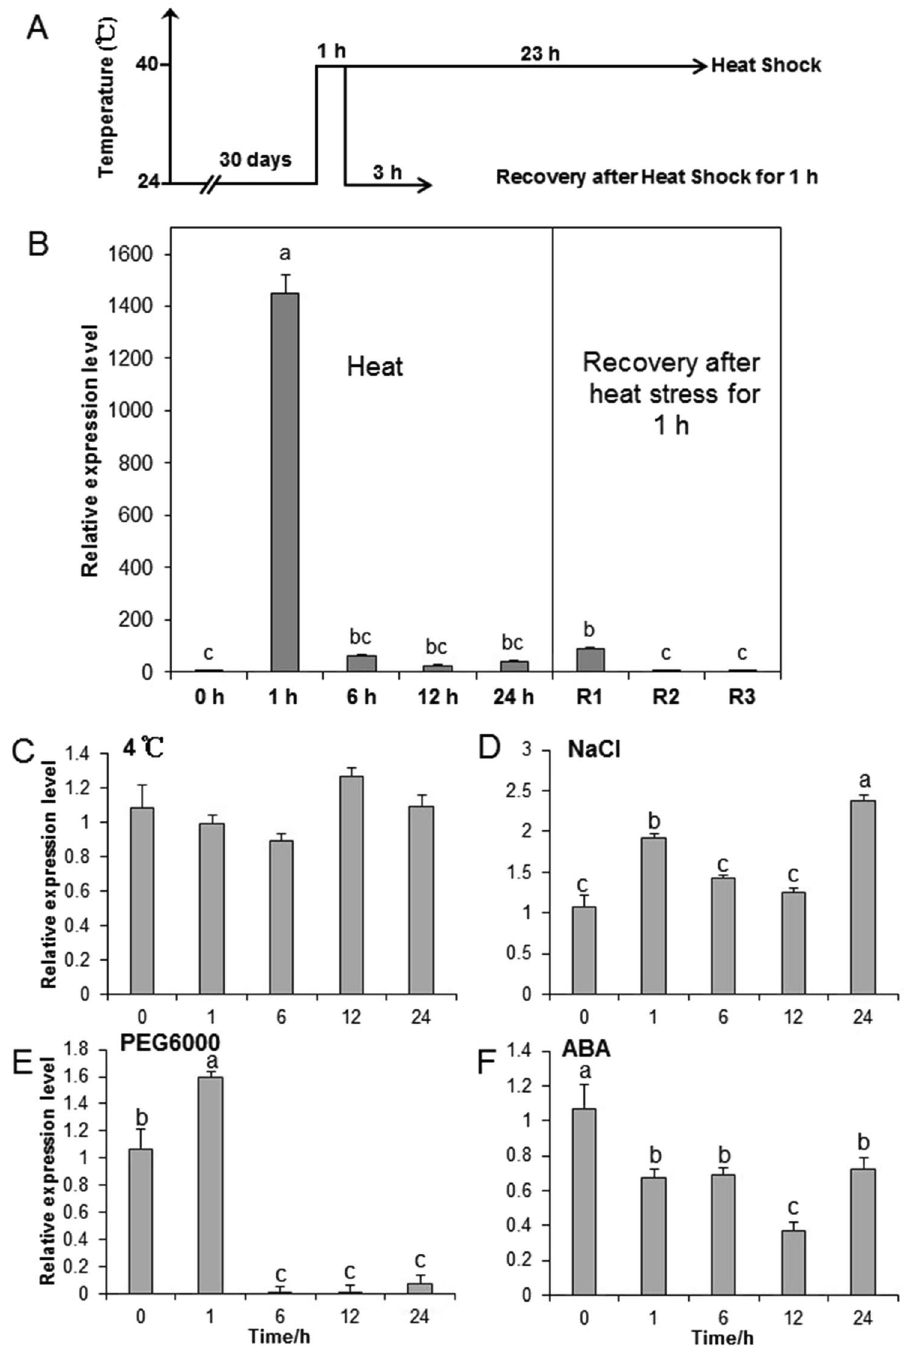
Figure 2. Transcription profiles of CsHSP17.2 gene under abiotic stress. ( A ) Schematic diagram of heat stress and recovery. ( B ) CsHSP17.2 expression levels under heat stress and recovery. R1, R2 and R3 indicate recovery from heat shock (HS) for 1, 2, and 3 h, respectively. Tea plants exposed to low temperature (4 °C) ( C ), 300 mM NaCl ( D ), 20% (w/v) PEG6000 ( E ) and 50 µ M ABA ( F ). Different letters indicate significant differences ( P < 0.05) between treatments and the control (0